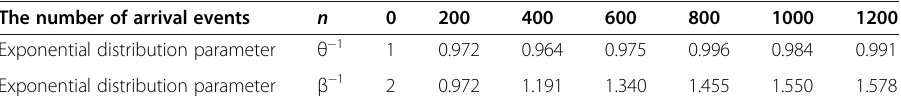
Table 3 Correction value of distribution parameters The number of arrival events